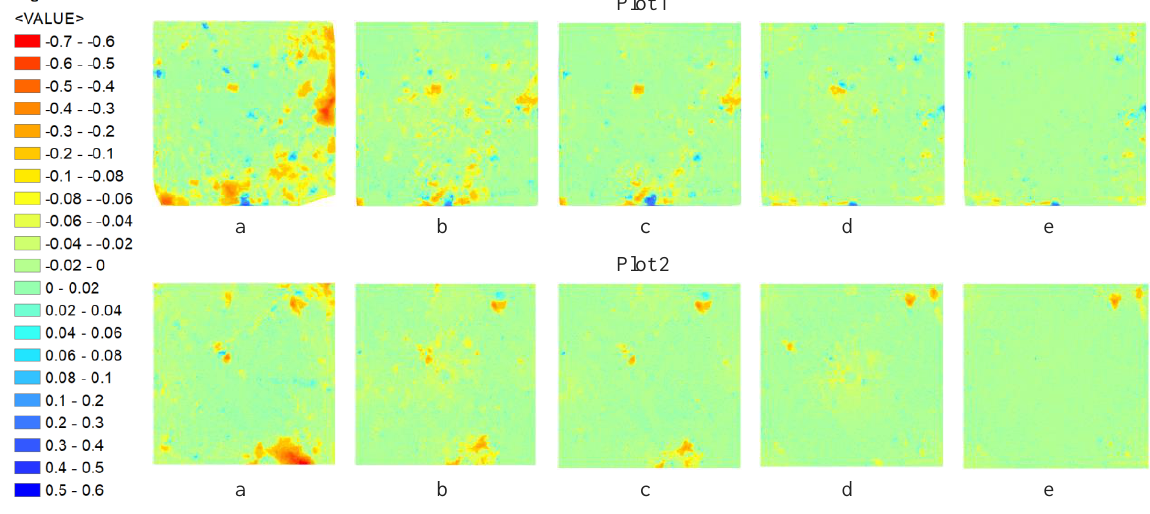
Figure 7 . Shows the relative difference between DTM obtained with ANS - Reference combination and different